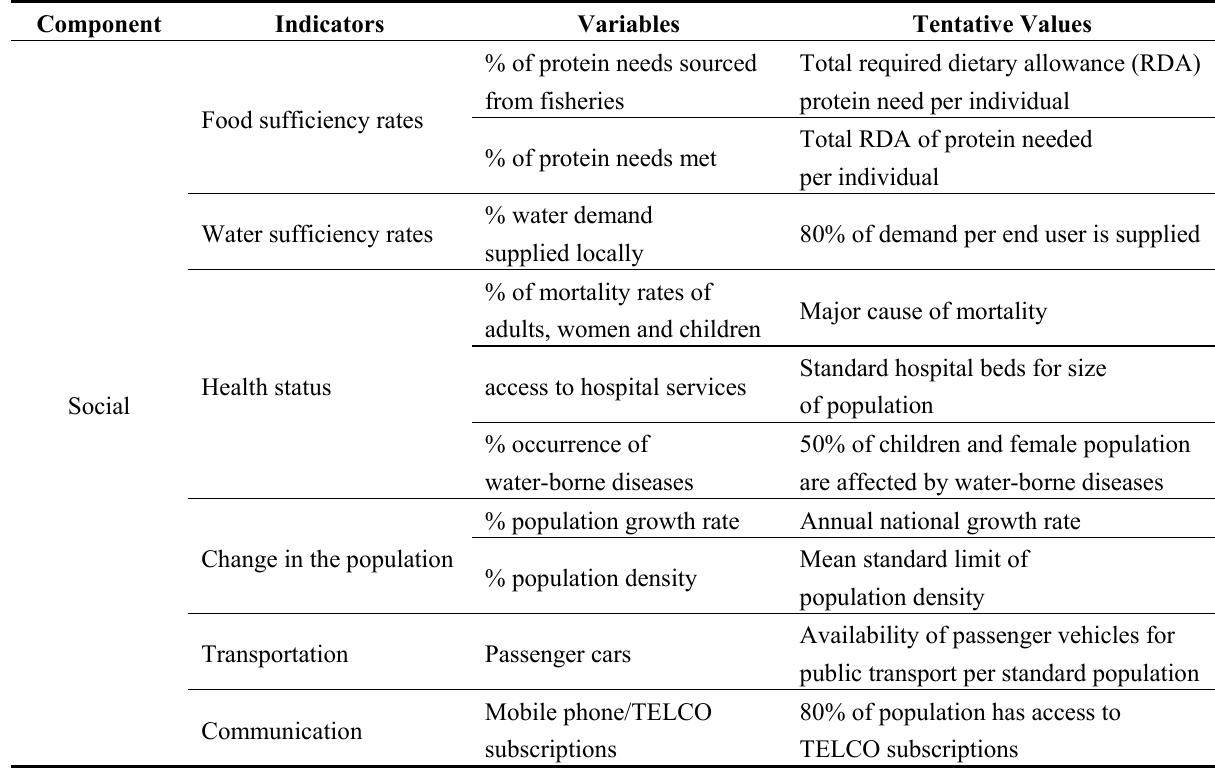
Table A1. Selected indicators of the social component for the analysis of the water and food nexus in Laguna de Bay,